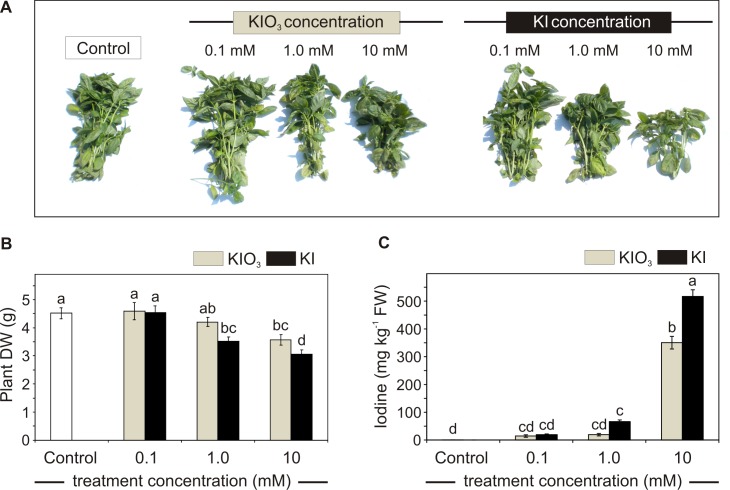
Effect of iodine on plant growth in open field experiment.Basil phenotype of control and KI or KIO3 (0, 0.1, 1.0 and 10 mM) treated plants at harvest (A); effects of increasing iodate od iodide concentrations on basil dry weight (DW) (B) and leaf iodine content (C). Error bars are presented on graphs. One-way ANOVA was performed. Different letters indicate significant differences between treatments (Tukey’s test, P≤0.05).